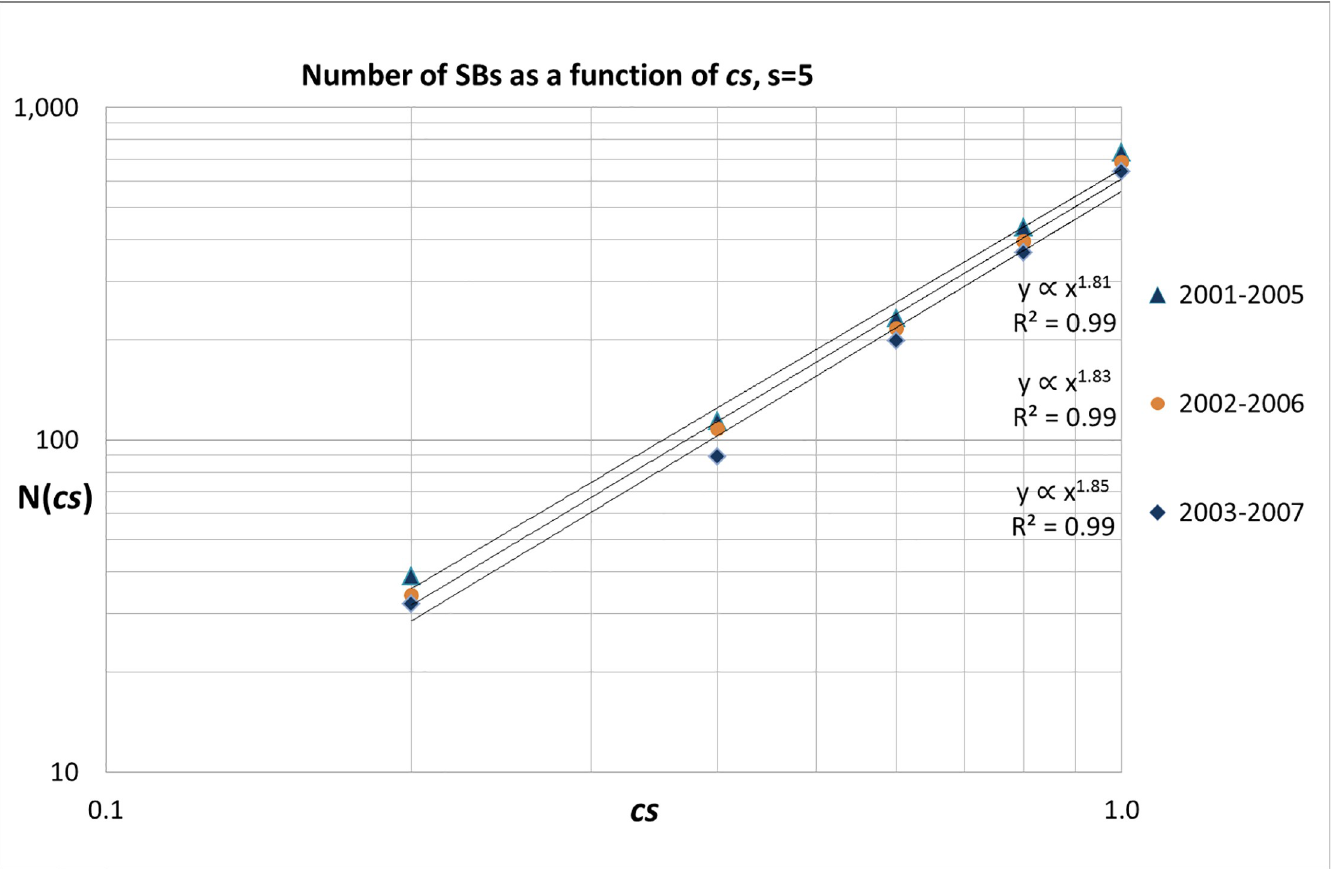
Fig 8. Number of SBs ( s = 5) for successive during-sleep citation-intensity ( c